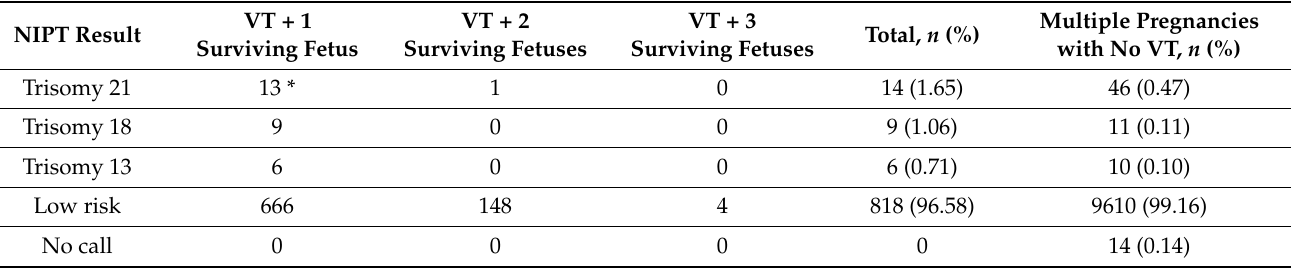
Table 3. NIPT results in our study cohort.